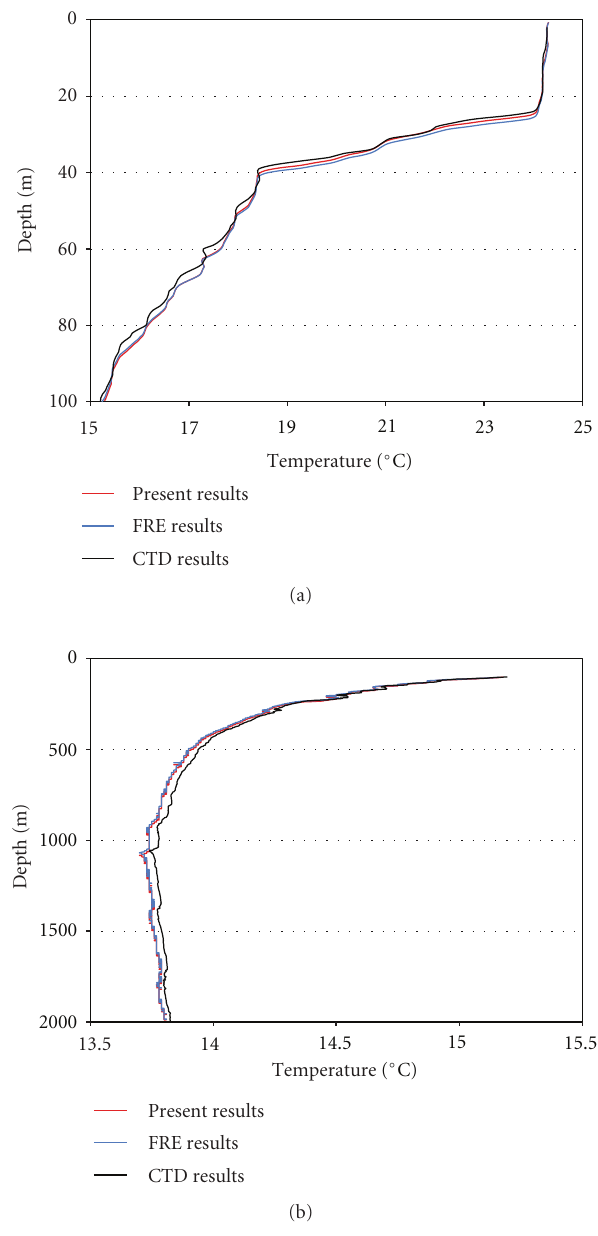
Figure 8: Comparison of the present method and the manufacturer FRE with a collocated CTD